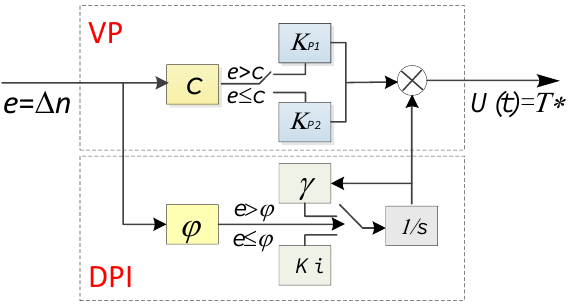
Figure 7. The structure diagram of VPDPI regulator control